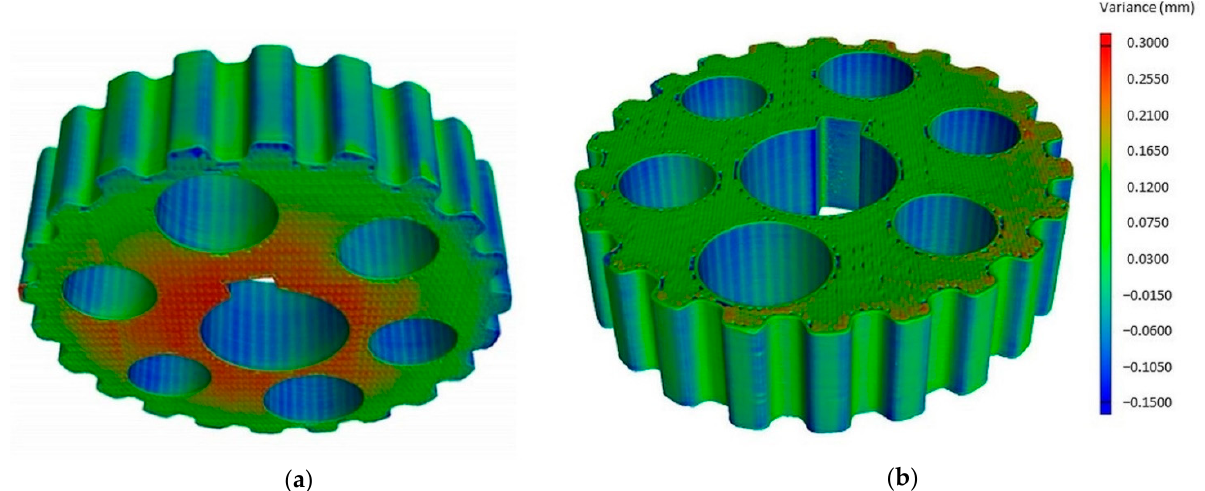
Figure 6. Comparison of the geometric features of the CAD model and the obtained surface model as a result of digitization of a non-circular pulley using a computer tomography: ( a ) upper view of toothed-wheel rim; ( b ) bottom view of toothed- wheel rim.